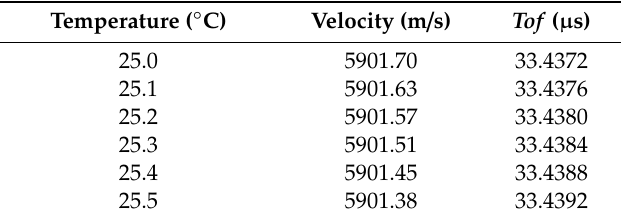
Figure 2. Recorded tone burst. Table 2. Time of flight variation with temperature.